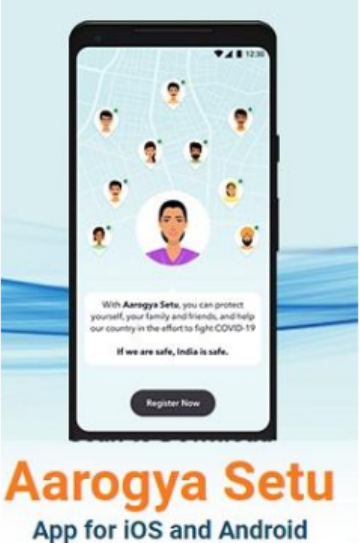
Figure 1. The Aarogya Setu